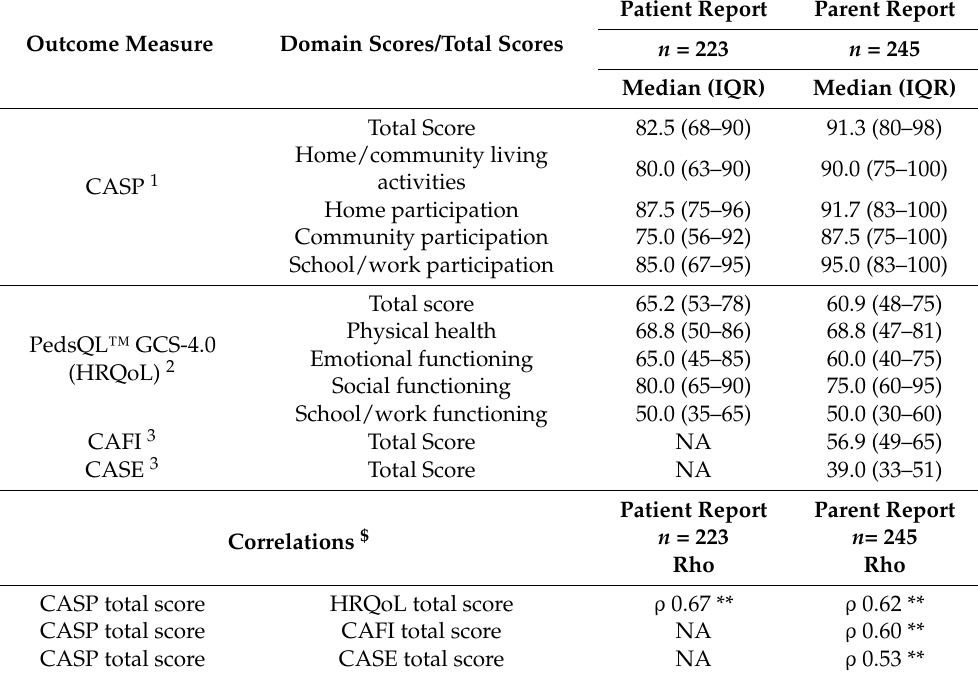
Table 2. Total and domain scores on the CASP, CAFI, CASE and PedsQL™ GCS-4.0 (HRQoL) of children and young adults with acquired brain injury (ABI) and mutual